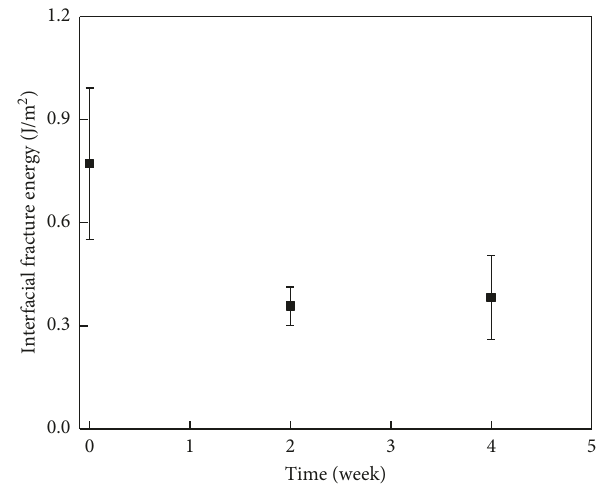
Figure 8: Degradation of the interfacial fracture energy with ex- posure